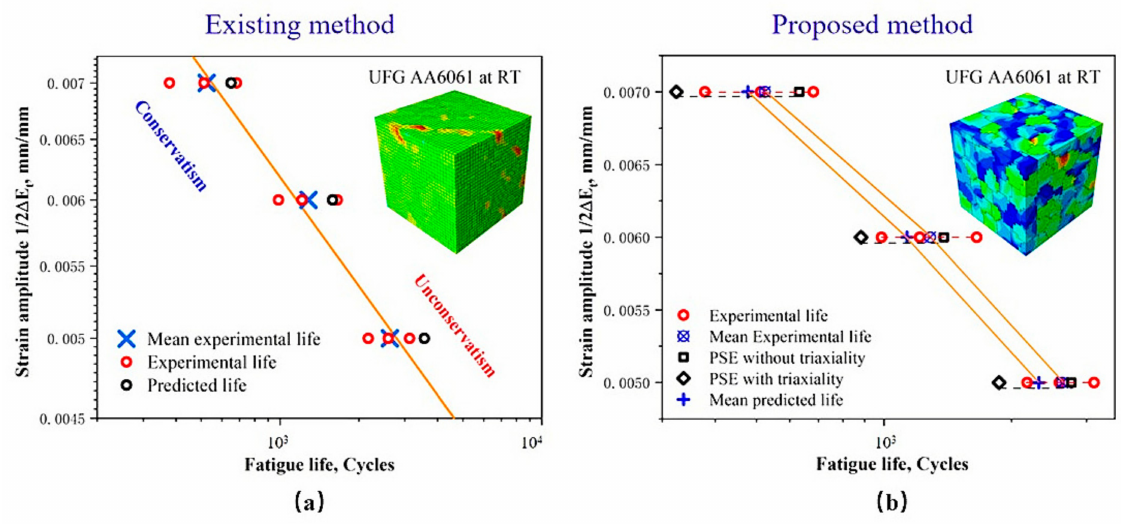
Figure 9. Comparisons between the predicted LCF lives and experimental ones: the existing predic- tion approach based on ( a ) plastic strain range; ( b ) The proposed prediction approach based on the combined influence of multiaxial strain and